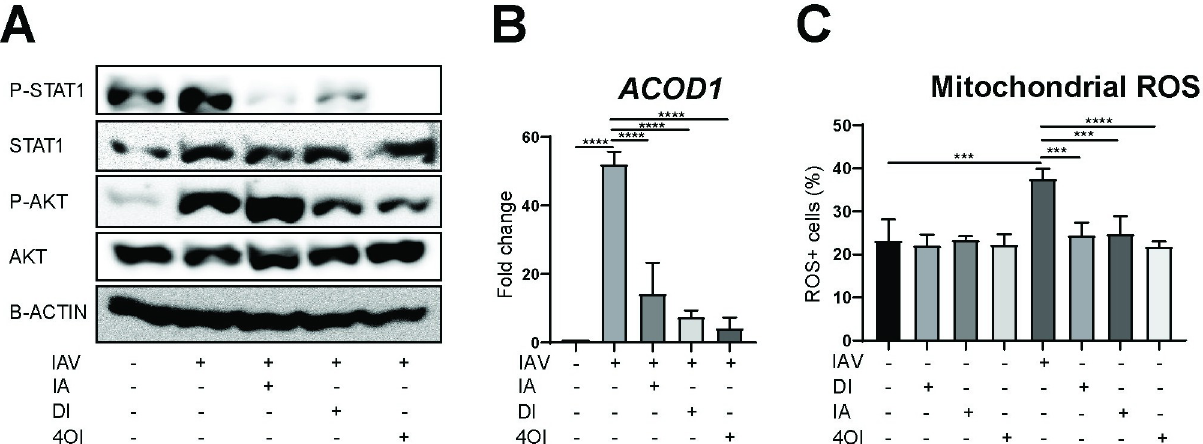
Fig 6. Effects of itaconates on phosphorylation of STAT1 and AKT, ACOD1 mRNA expression, and ROS levels. Treatments (itaconate, 20 mM; DI 0.5 mM; 4OI 125 μ M) were applied as indicated to dTHP1 cells infected with IAV (PR8M, MOI = 1), and analyses performed 12 h p.i. A. Itaconate, DI, and 4OI inhibit STAT1 phosphorylation, but only DI and 4OI inhibit AKT phosphorylation (immunoblot for the indicated targets, using β -actin as internal control). B. 4OI exerts the strongest ACOD1 mRNA reduction (RT-qPCR, n = 3). Reference for fold change = uninfected cells 12 h. C. The three itaconates reduce IAV-induced mitochondrial ROS levels to a similar degree (flow cytometry, n = 3). Mean ± SEM � p < 0.05; �� p < 0.01; ��� p < 0.001 (1-way ANOVA followed by Tukey’s multiple comparison test).